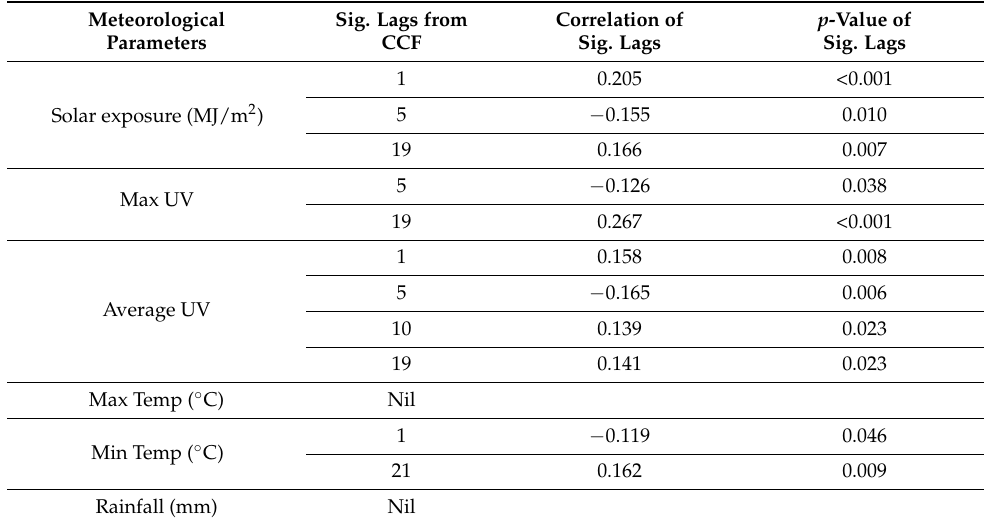
Table 4. Significant correlations for each meteorological variable were identified from the CCF after pre-whitening.